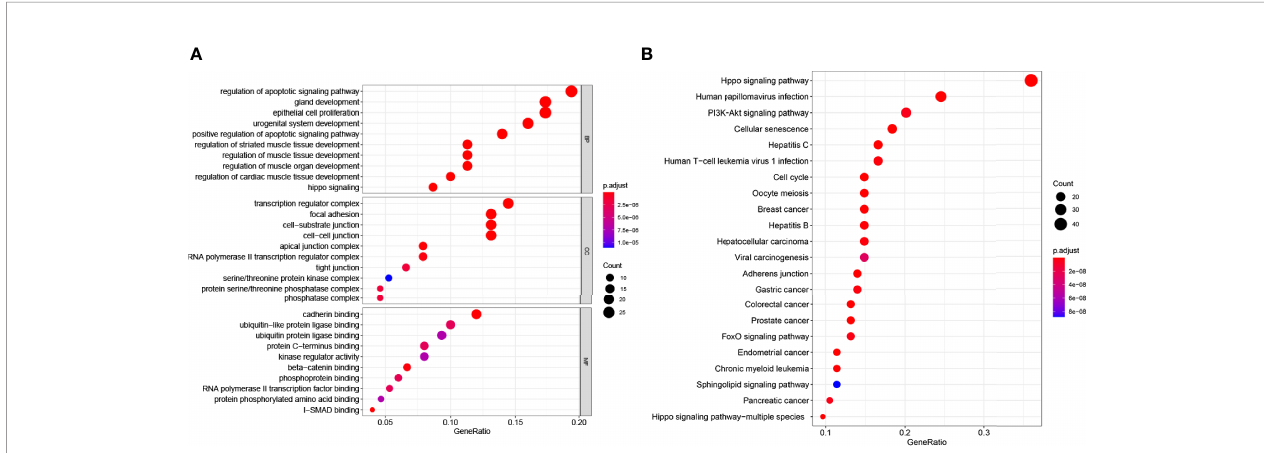
FIGURE 2 | GO and KEGG enrichment analysis of the 155 genes signi fi cantly associated with YAP. (A) The abscissa is the percentage of genes under the GO functional module (ratio); the ordinate is the GO functional module: BP (biological process), CC (cell composition), and MF (molecular function). (B) The x- coordinate in the fi gure is the number of DEGs annotated to KEGG pathway/the total number of differentially expressed genes (ratio); the ordinate is the KEGG pathway. The size of the point represents the number of DEGs annotated to the KEGG